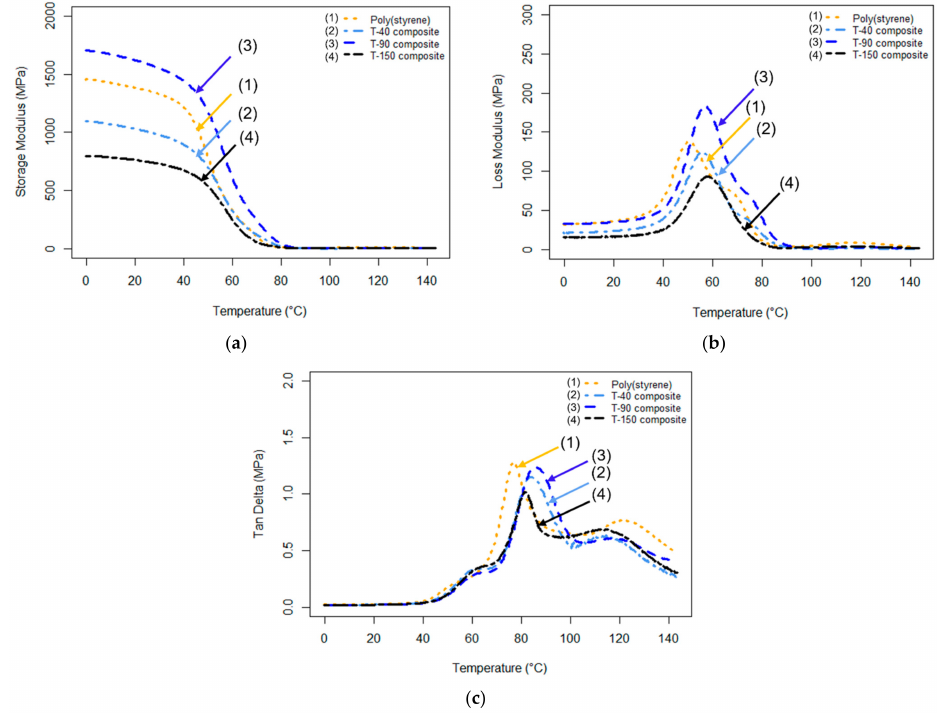
Figure 13. DMA thermograms of tested samples. ( a ) Storage modulus E (cid:48) of poly(styrene), ( b ) Loss modulus E (cid:48)(cid:48) , ( c ) Tan δ of (1) poly(styrene), (2) T-40 composite, (3) T-90 composite and (4) T-150